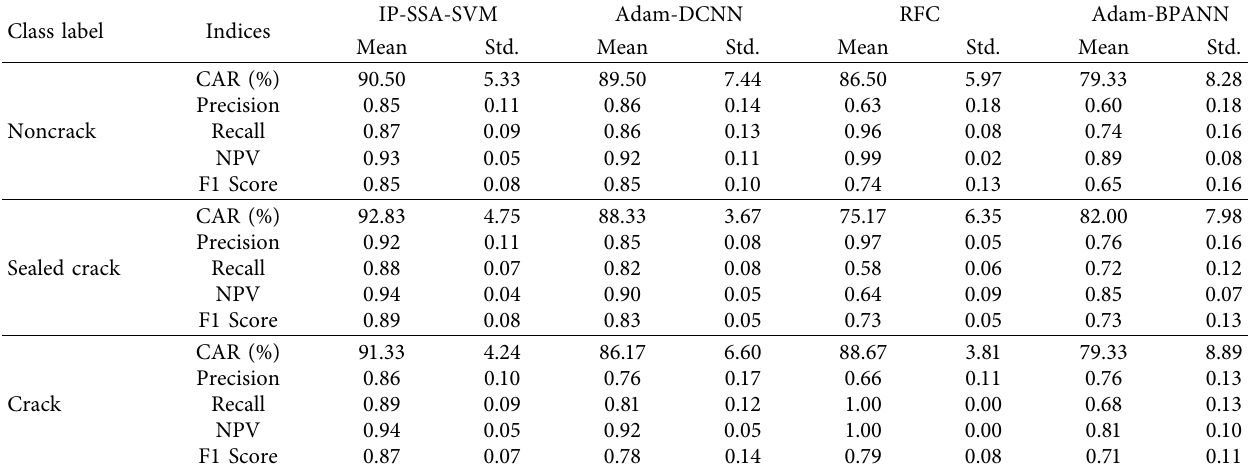
Table 2: Prediction performance comparison